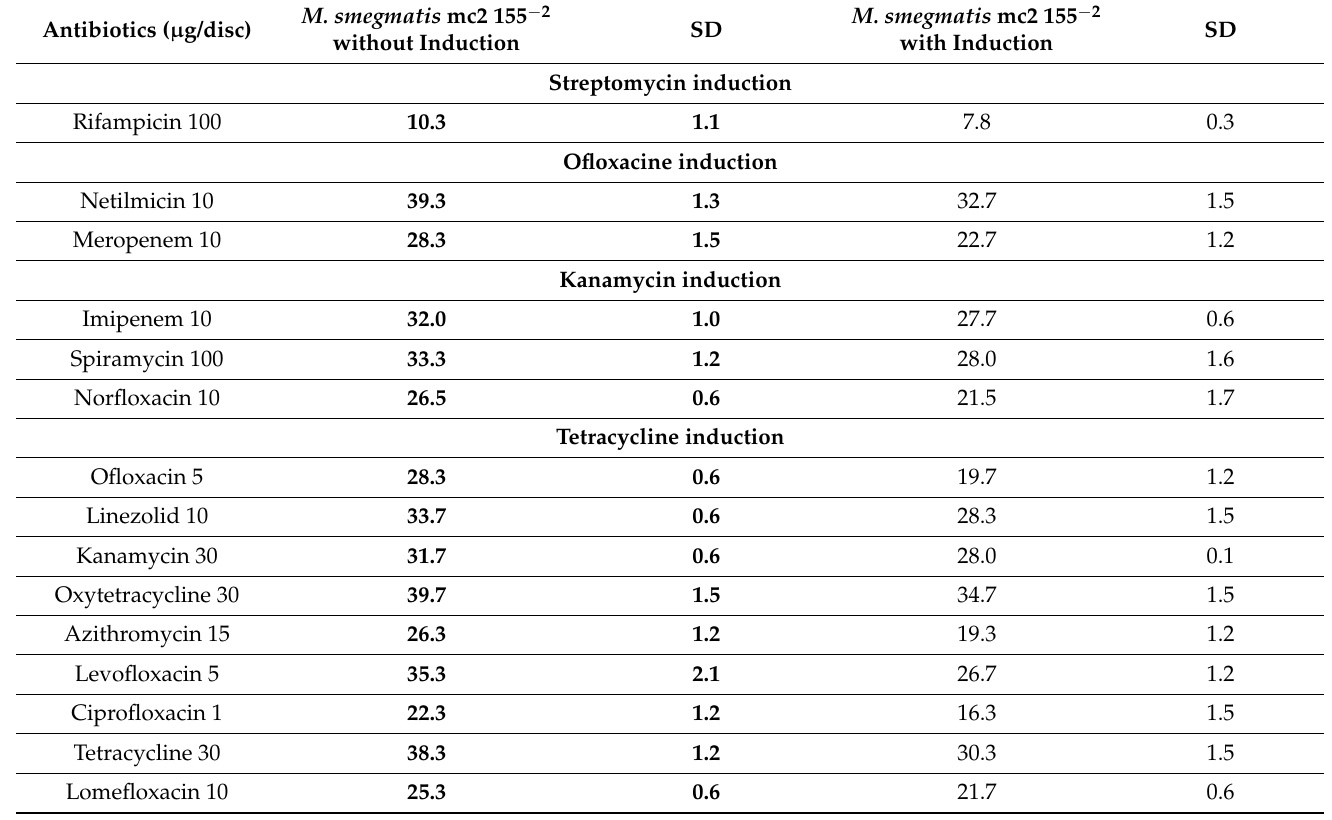
Table A2. Data from drug susceptibility testing. Diameters of growth inhibition halos produced by different antibiotics, with and without induction, by low doses of antibiotics on cultures of M. smegmatis mc2 155 − 2 . The columns represent the mean value from five independent experi- ments (mm), SD—standard deviations from five independent